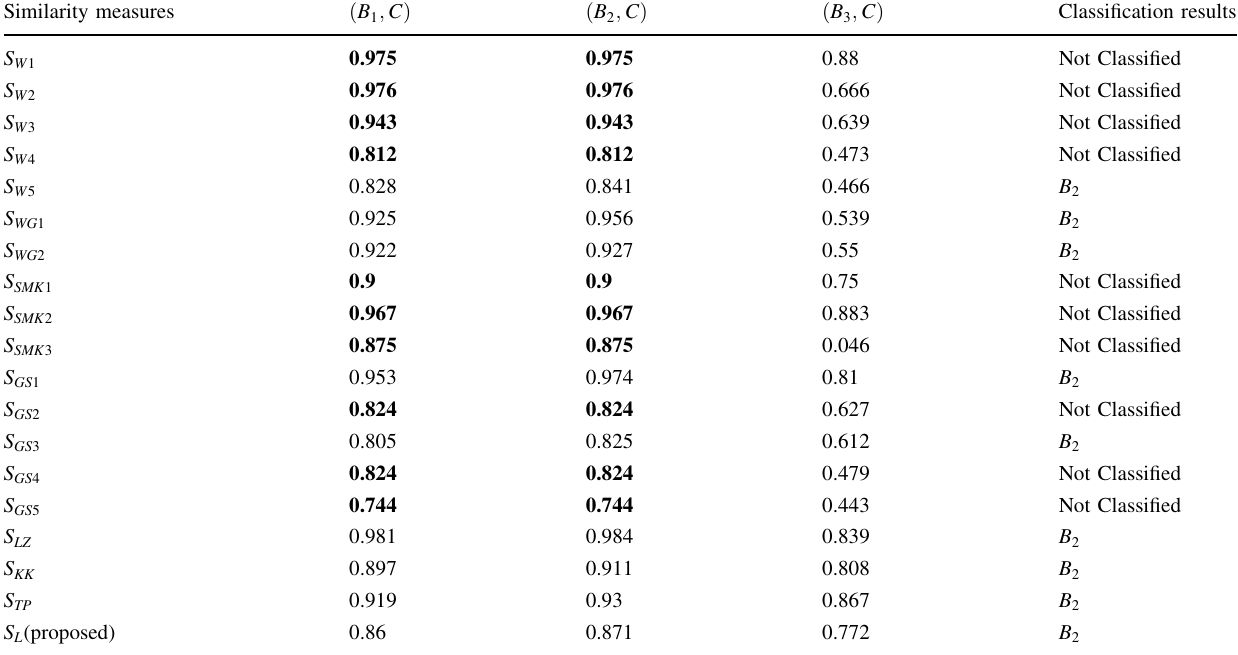
Table 5 The results of different similarity measures for pattern recognition Similarity